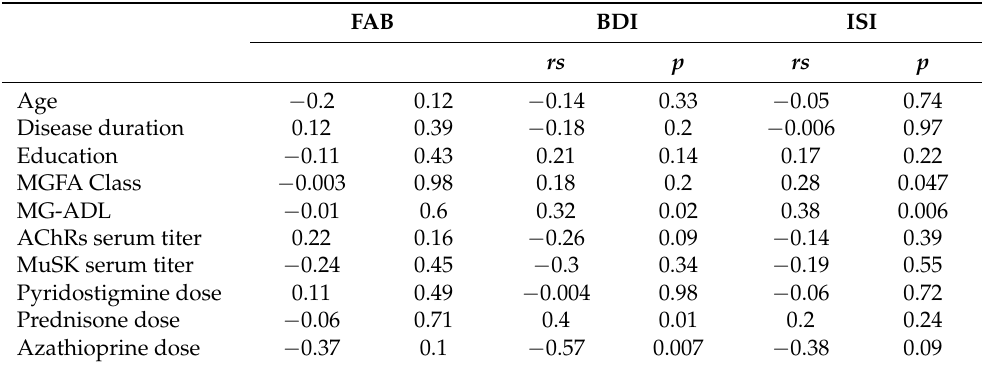
Table 4. Correlation analyses between cognitive and behavioral testing and demographic, clinical, and immunological variables in MG